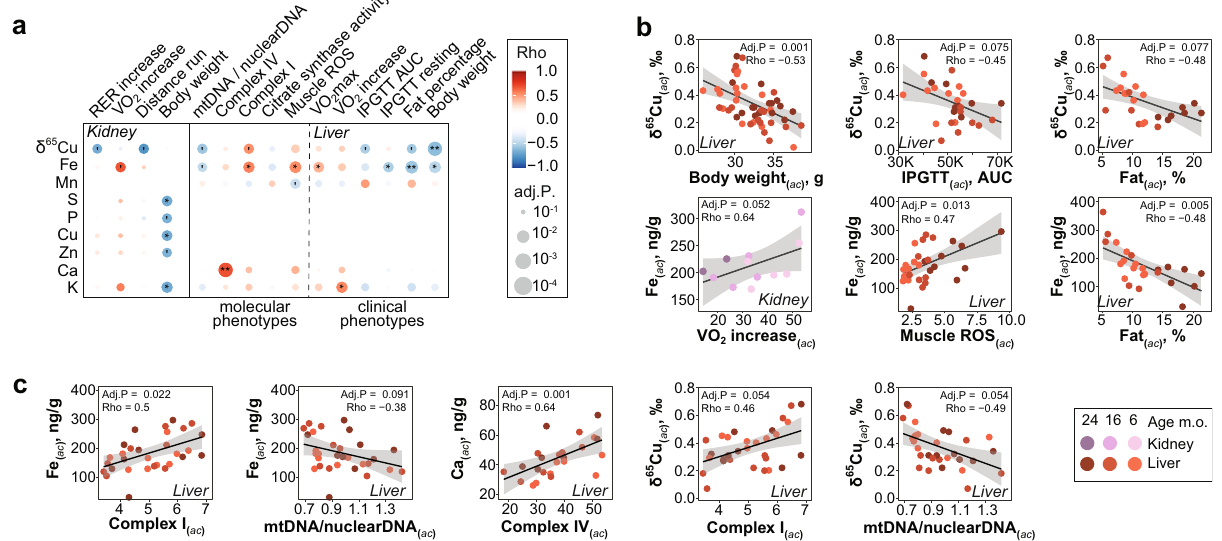
Fig. 3 Metals and isotope compositions, notably Fe and δ 65 Cu in liver and kidney associate with metabolic traits. a Signi fi cant correlations between metabolic phenotypes and metals in the liver and kidney. There were no signi fi cant associations in other organs except for a single one in the heart. This is consistent with the central role of liver and kidney in the control of metabolic traits. ***Adj. P < 0.001, **Adj. P < 0.01, *Adj. P < 0.05, ‘ Adj. P < 0.1. b , c Dot plots of the individual correlations of δ 65 Cu ( b ) and Fe ( c ) with indicators of obesity (body weight, fat %), diabetes (Intra-peritoneal glucose tolerance test, area under the curve, IPGTT AUC), and muscle activity (Muscle ROS) and running performance (VO 2 increase), as well as the activity of mitochondrial complex I. The subscripts ( ac ) stand for “ age corrected ” . In all panels, Rho indicates the Spearman Rho coef fi cient, and Adj. P is computed by a moderated t - test (limma), two-sided and FDR-corrected with age as a covariate. In panels b and c , the black line and gray error band represent a simple linear regression and its 95% con fi dence interval, respectively. Source data are provided as a Source Data fi